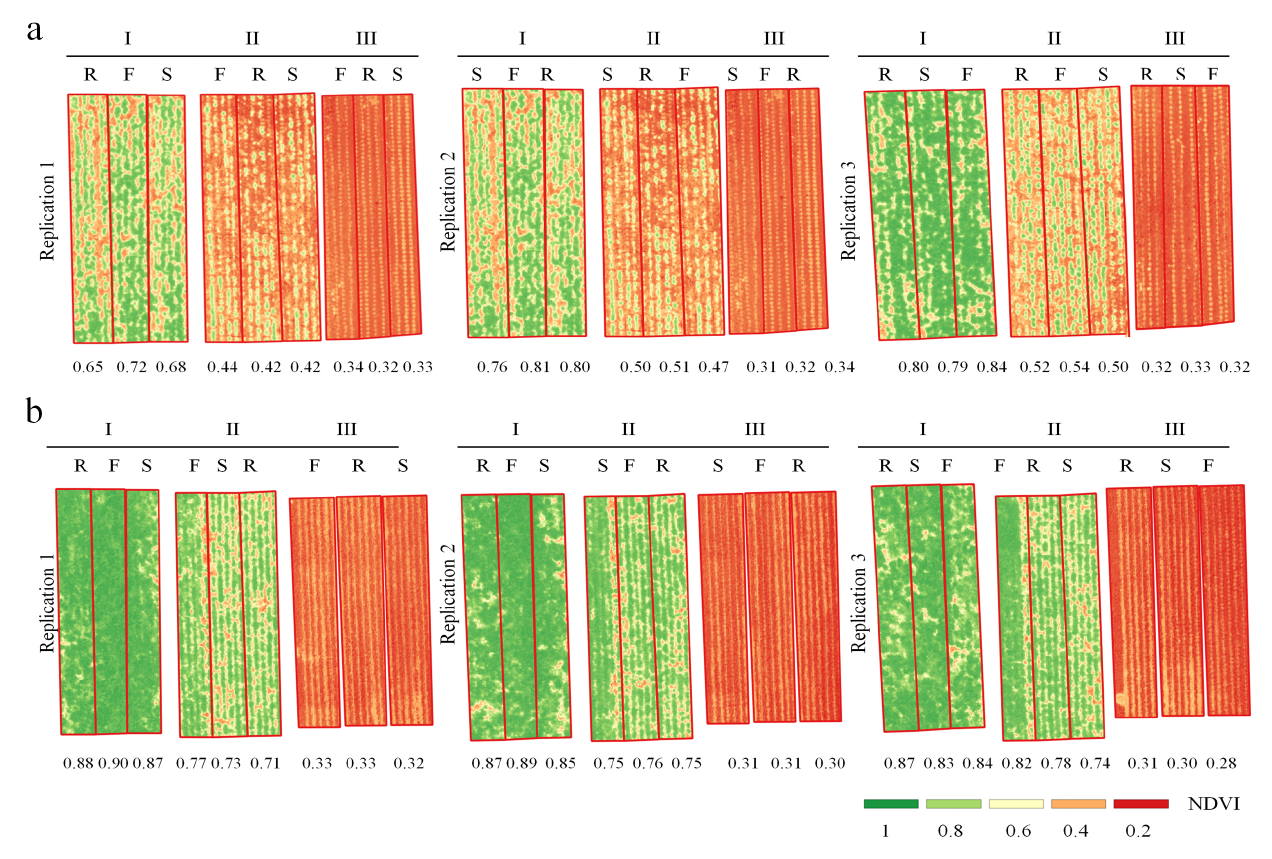
Figure 10. Average NDVI by irrigation treatments (F, R and S) and sowing periods (I, II, and III) on 4 July 2019 ( a ) and 3 July 2020 ( b